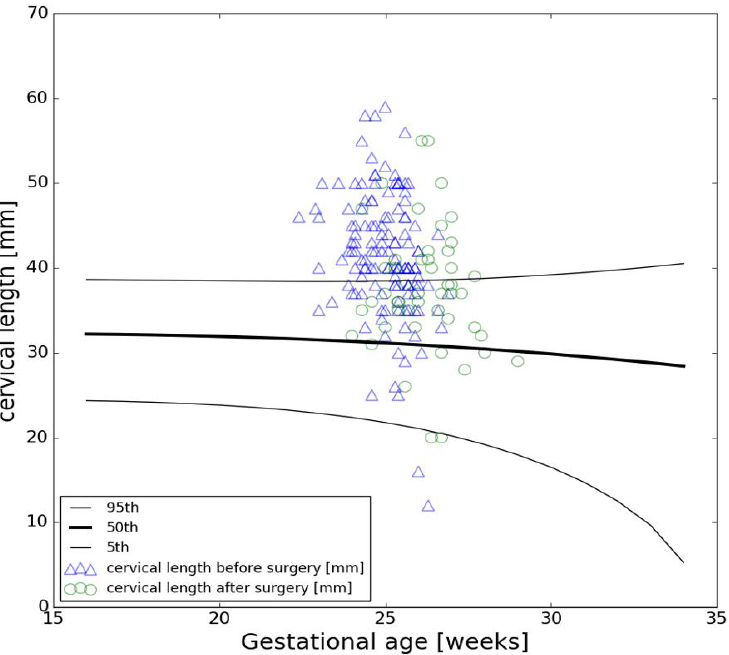
Figure 1. Overview of cervical length measurements before and after surgery on the nomogram by